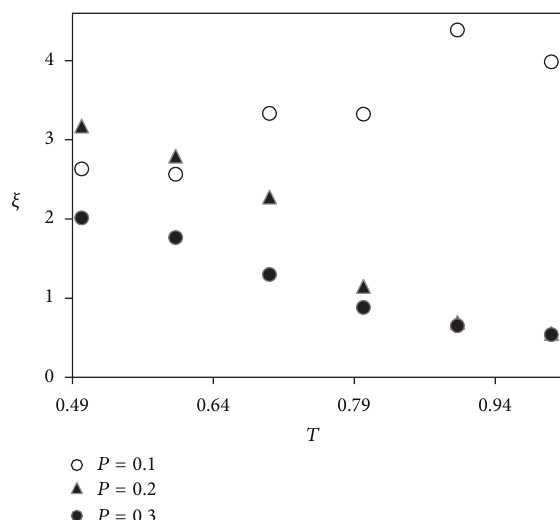
Figure 8: The domain size temperature dependence of SRO struc- tures shown in Figure 7, obtained from random histories . 𝑁 = 60 , 𝑊 = 1 .